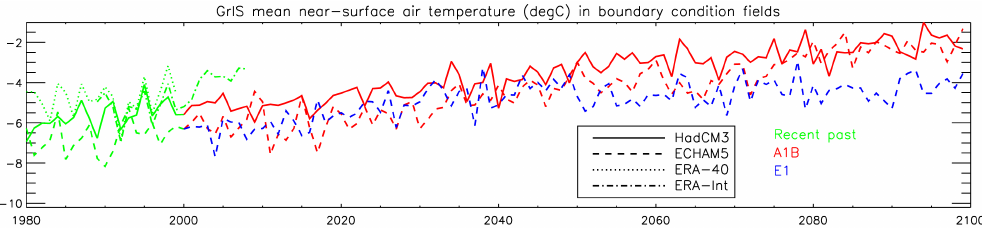
Fig. 1. Time series of near-surface air temperature (1.5m in HadCM3, 2m in the other data sets) from the HadCM3 and ECHAM5 simulations used for boundary conditions, and from ERA-40 and